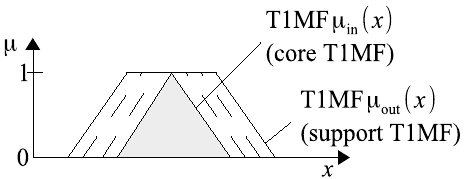
Figure 10. An example of a possible distribution of T1FS expert evaluations of a certain fuzzy